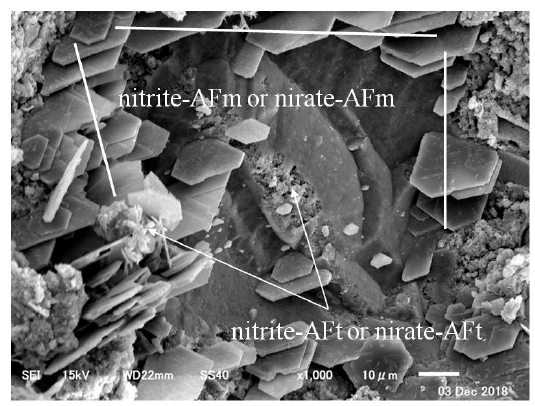
Figure 13. CN13 (×5000)–1. Figure 13. CN13 ( × 5000)–1.